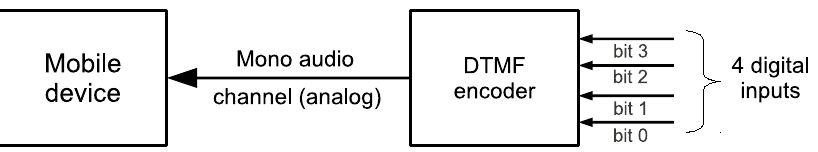
Figure 3. Sensors input using a DTMF